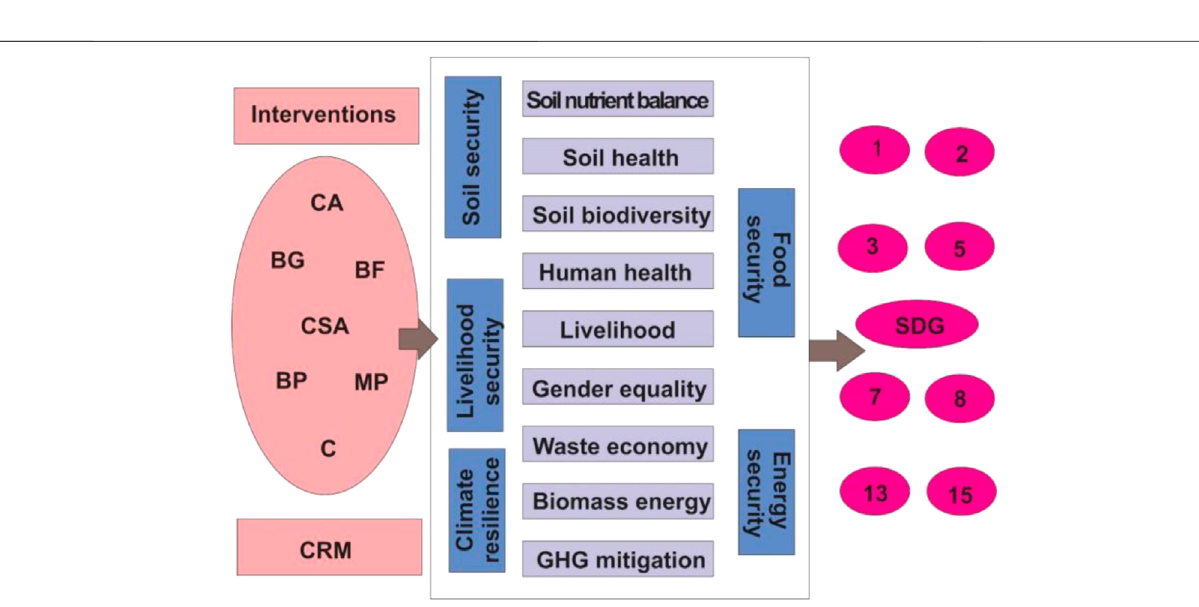
Frontiers in Energy Research |